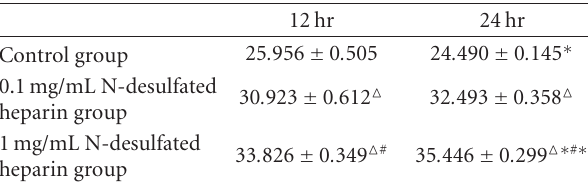
Table 3: bFGF mRNA expression of gastric cancer SGC-7901 cell in di ff erent concentrations (0.1mg/mL, 1mg/mL) of N-desulfated heparin groups and control group (ct value, x ± s , n = 3).